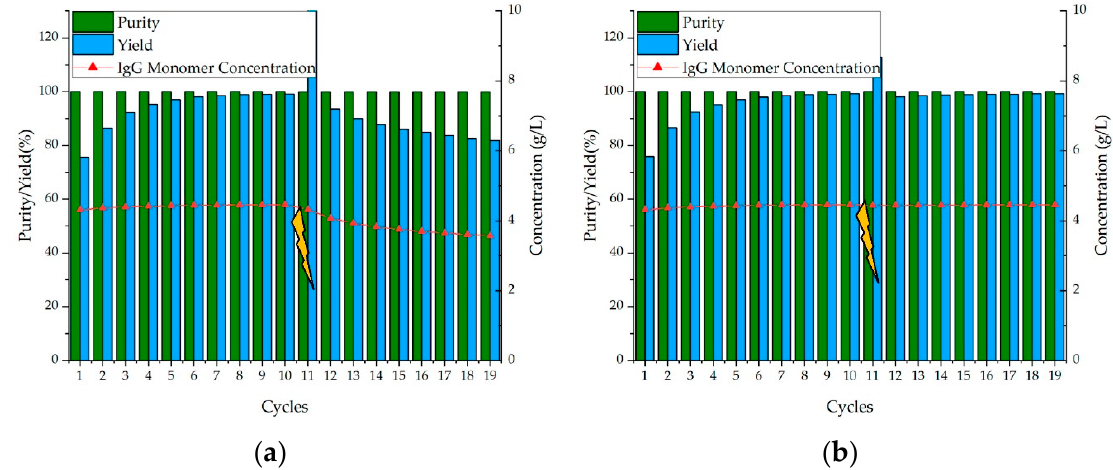
Figure 17. Purity, yield, and concentration course over cycles. ( a ) is without process control, ( b ) is with valve control via PAT concentration measurement. Volume disturbance occurs in cycle 11.